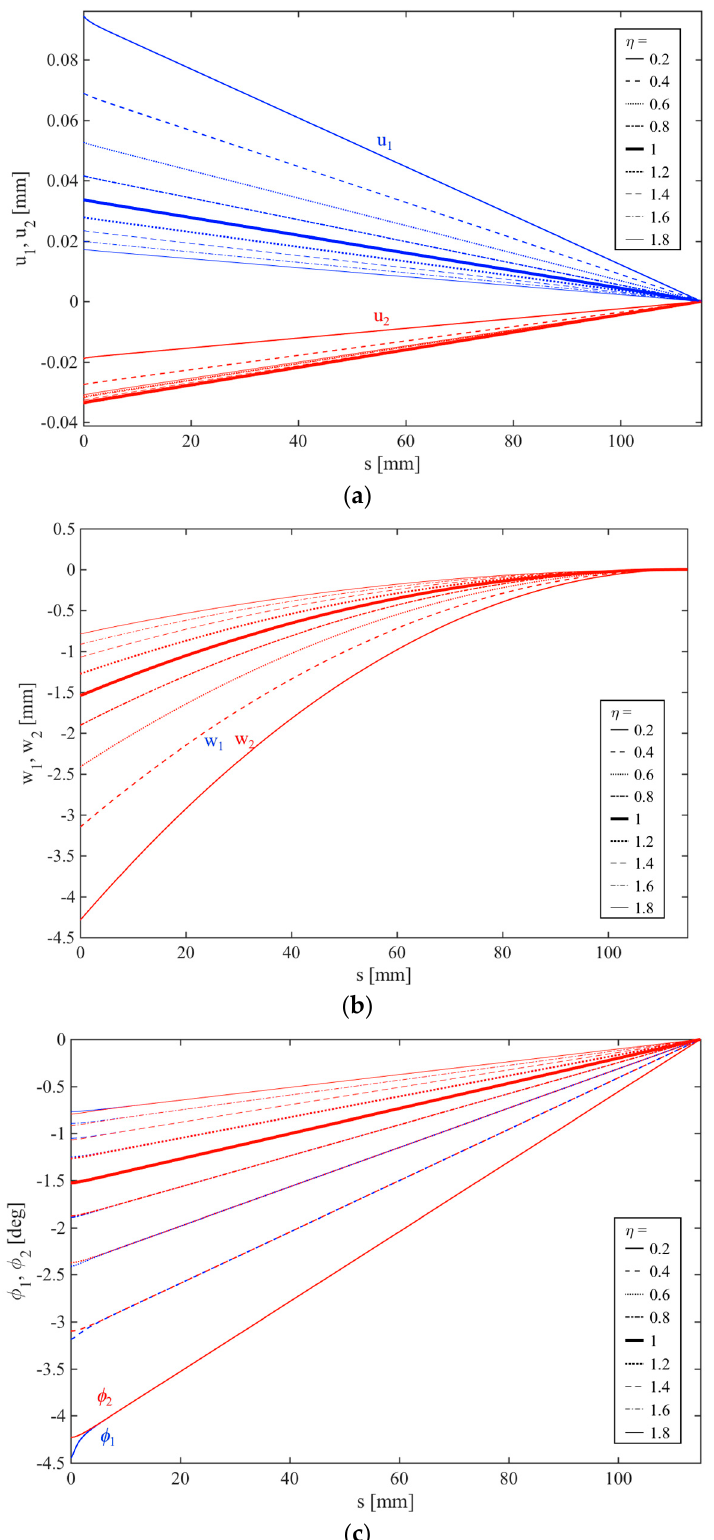
Figure 14. Effect of the thickness ratio η on the kinematic response of the sublaminates: ( a ) Axial displacement; ( b ) Shear displacement; ( c ) Cross-sectional rotation. (Isotropic specimen).